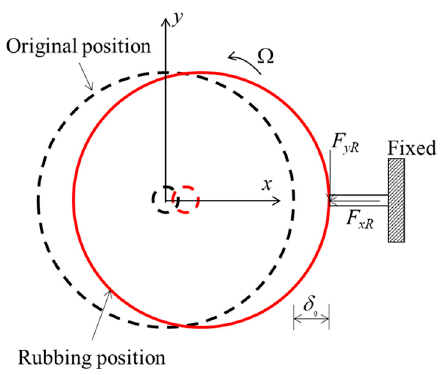
Figure A2. Schematic of a single rub-impact between the rotor and